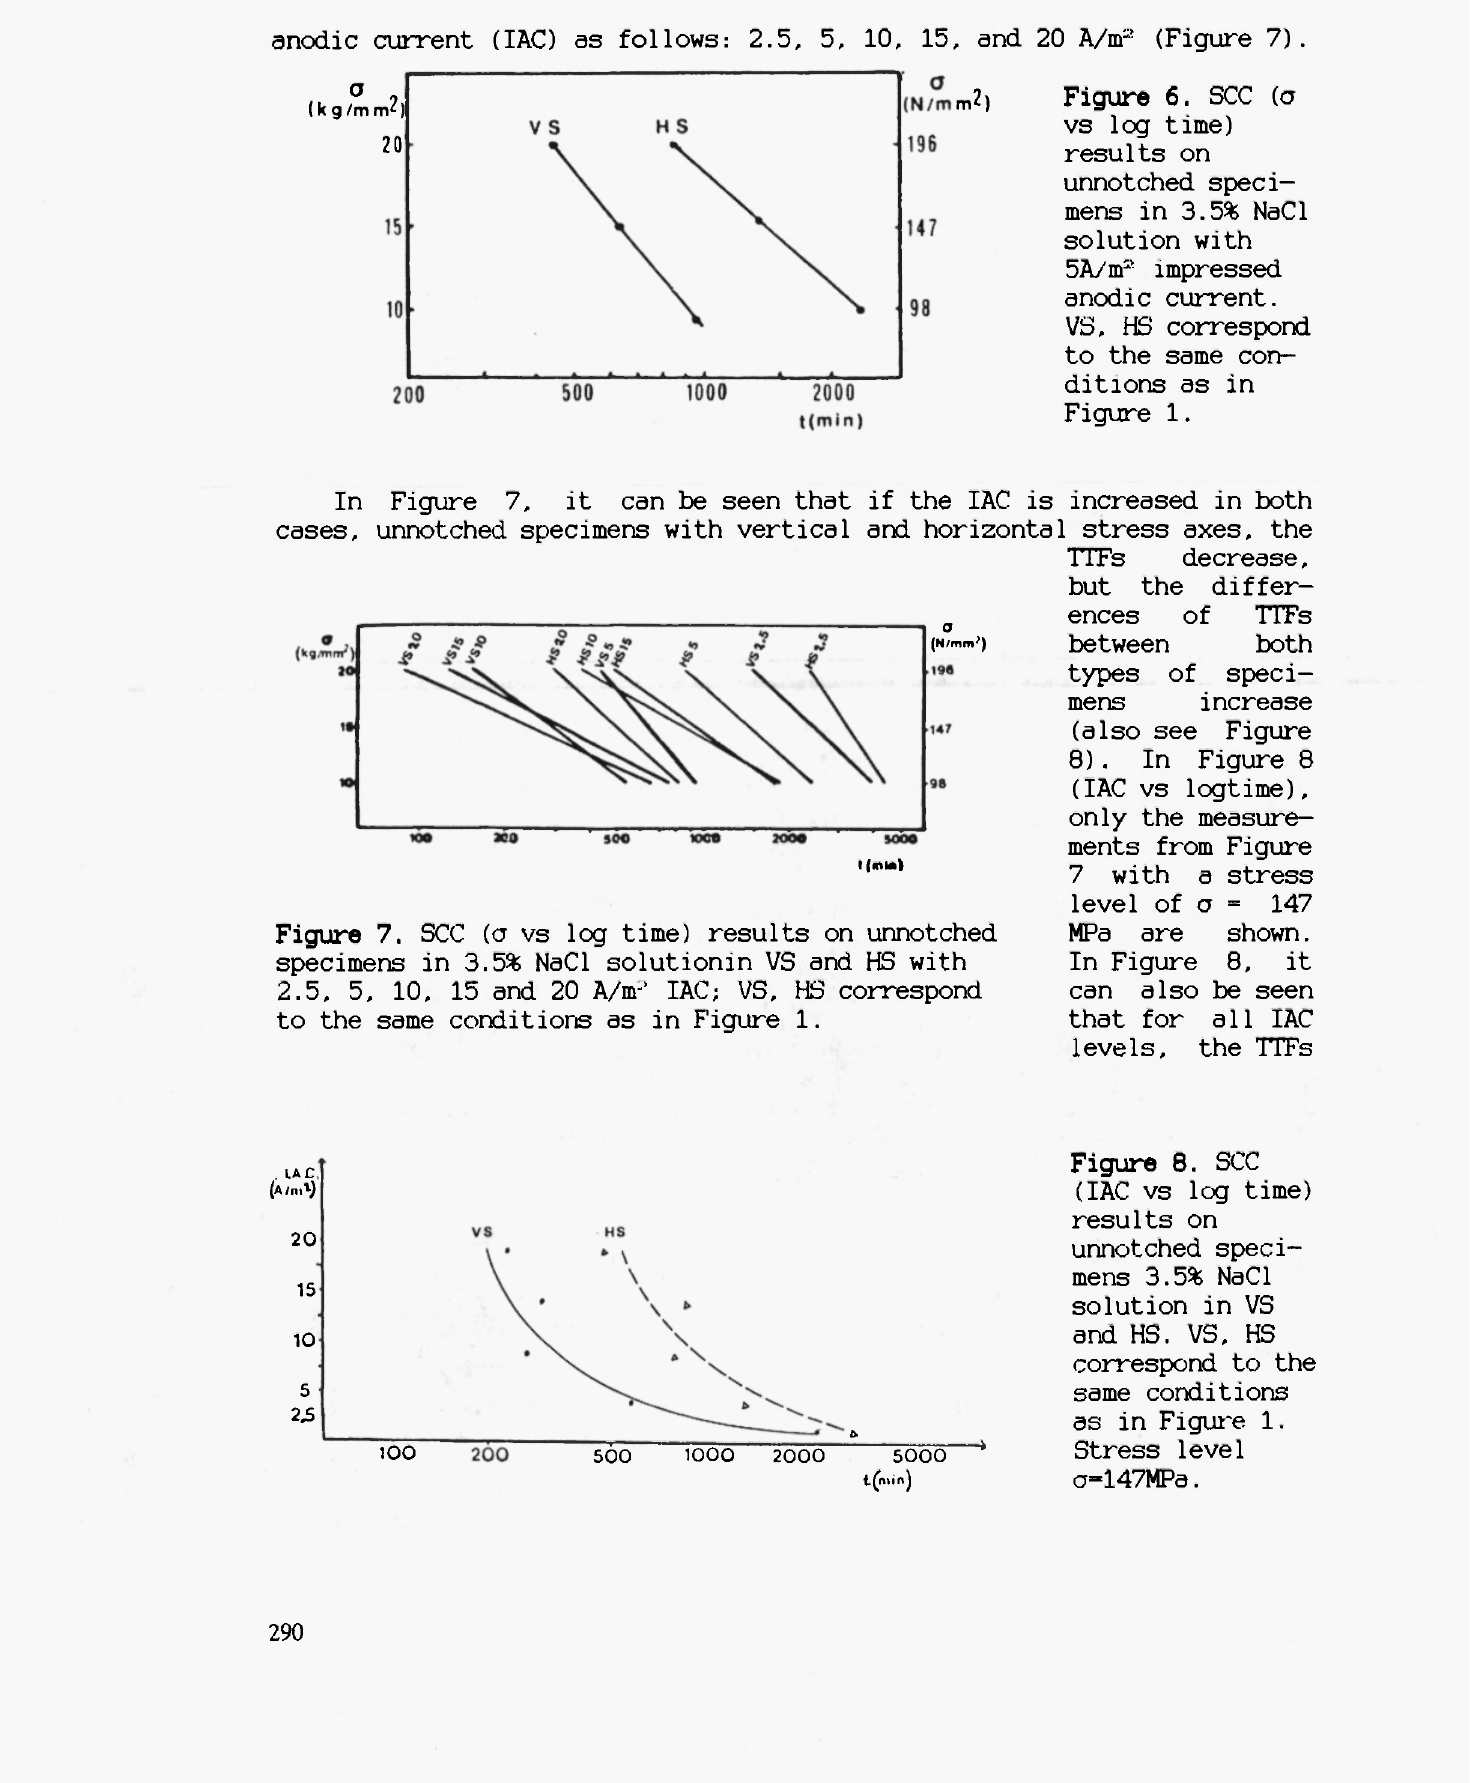
Figure 6. SCC (σ vs log time) results on unnotched speci- mens in 3.5% NaCl solution with 5A/m 2 impressed anodic current. VS, HS correspond to the same con- ditions as in Figure 1.